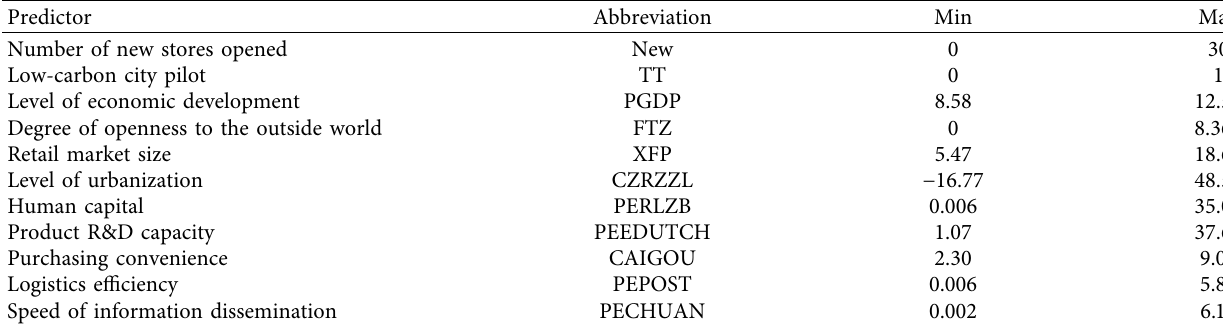
Table 2: Predictors of